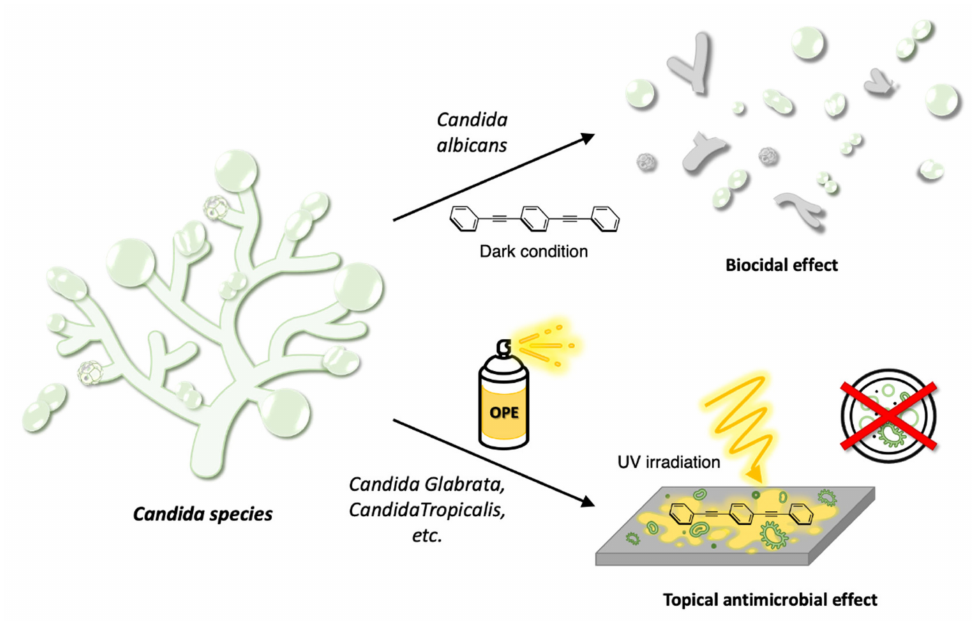
Figure 11. Cartoon representation of effect of some OPEs on Candida